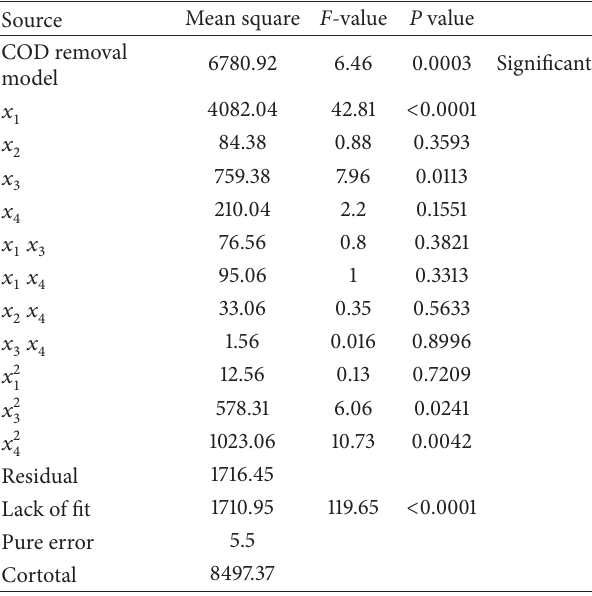
Table 5: ANOVA for RSM (ANOVA table).